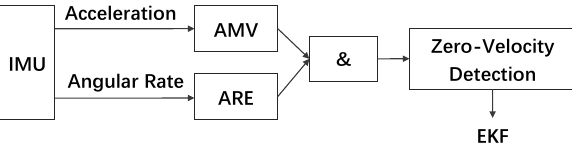
Figure 3 . Comparison of heading orientation and trajectory orientation. Blue arrow is the heading orientation while red arrow is the trajectory